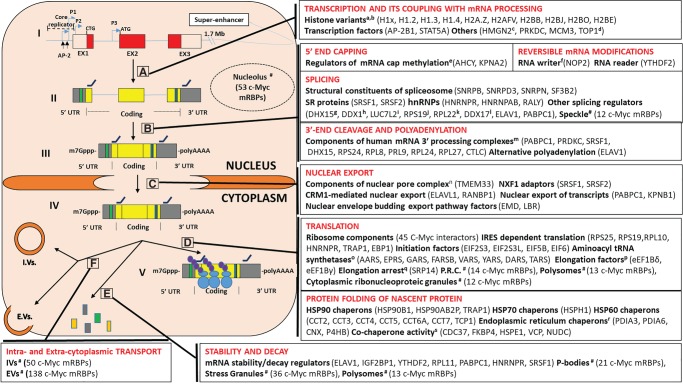
c-Myc mRNA processing and related HyPR-MS identified interactors. c-Myc processing, starting with the gene (I) and the following transcription into pre-mRNA (II), nuclear (III) and cytoplasmic (IV) mature mRNAs, and finally ending with mature mRNA immediately prior to translation. c-Myc RBPs identified using HyPR-MS are listed in boxes corresponding to specific phases of c-Myc mRNA processing, and some occur in multiple boxes if they are involved in several processing roles. (A) Transcription-related c-Myc proteins did not include canonical histones, but histone variants that replace canonical histones can impact processes such as transcription and RNA processing (Tolstorukov et al. 2012; Henikoff and Smith 2015; Buschbeck and Hake 2017; Talbert and Henikoff 2017). (B) Maturation, including 5′ end capping, reversible mRNA modification, splicing and 3′ end cleavage and polyadenylation (C) Nuclear export (D) Translation (P.R.C. = perinuclear region of cytoplasm) and protein folding of the nascent protein (E) Stability and decay (F) Recent findings show vesicle-coupled transport for mRNP complexes in fungi, supporting the hypothesis of similar mechanisms of mRNA transport in higher eukaryotes (Jansen et al. 2014; Haag et al. 2015). In line with this, both IVs and EVs are enriched GO terms by gene ontology analysis (Supplemental Table S3). For proteins not explained in the text we refer to related citations delineating their roles in mRNA processing: a(Harshman et al. 2013), b(Bonenfant et al. 2006), c(González-Romero et al. 2015), d(Naro et al. 2015; Li and Liu 2016), e(Cowling 2009), f(Blanco and Frye 2014; Trixl and Lusser 2018), g(Murakami et al. 2017), h(Zhong et al. 2018), i(Singh et al. 2013), j(Orrù et al. 2007), k(Zhang et al. 2017), l(Dardenne et al. 2014), m(Shi et al. 2009), n(Kabachinski and Schwartz 2015), o(Hausmann et al. 2007), p(Li et al. 2013), q(Zhang and Shan 2012), r,s(Caplan 2003; Chen et al. 2005; Zheng et al. 2011; Saibil 2013; Halperin et al. 2014; Briones 2015; Gao et al. 2016; Narayanan et al. 2016). See Supplemental Table S3 for c-Myc RBPs belonging to these specific subgroups.